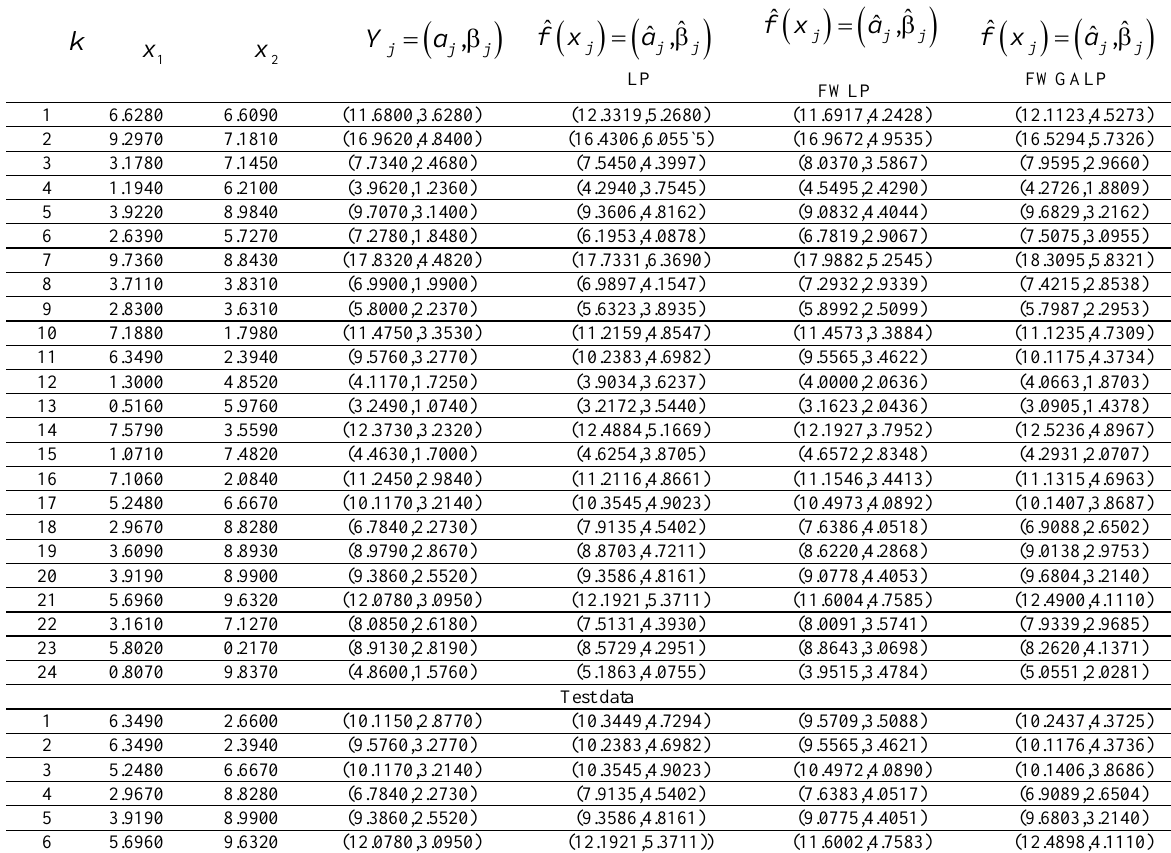
Table 3. Predicted fuzzy outputs using the different methods for Example 1 .